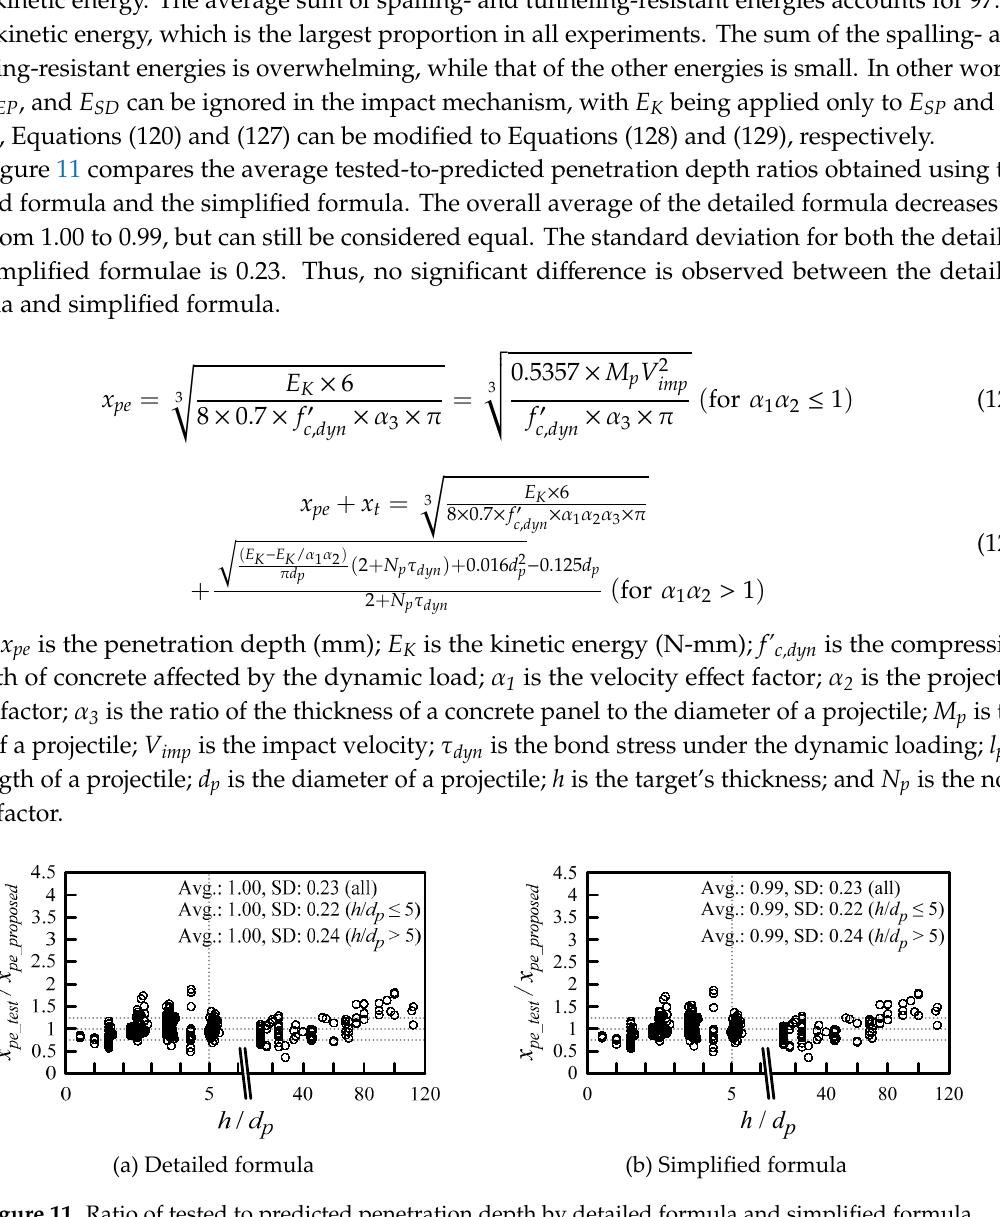
Figure 11. Ratio of tested to predicted penetration depth by detailed formula and simplified formula.